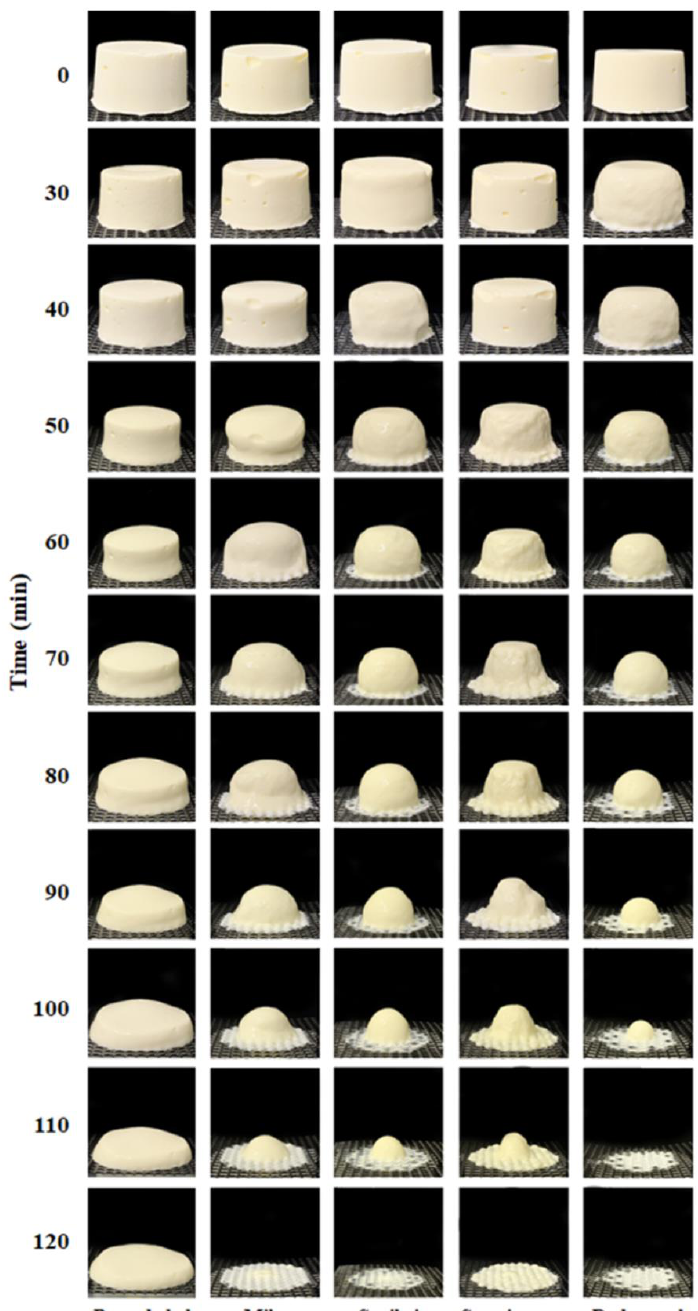
Figure 2. Photo of ice cream during the meltdown